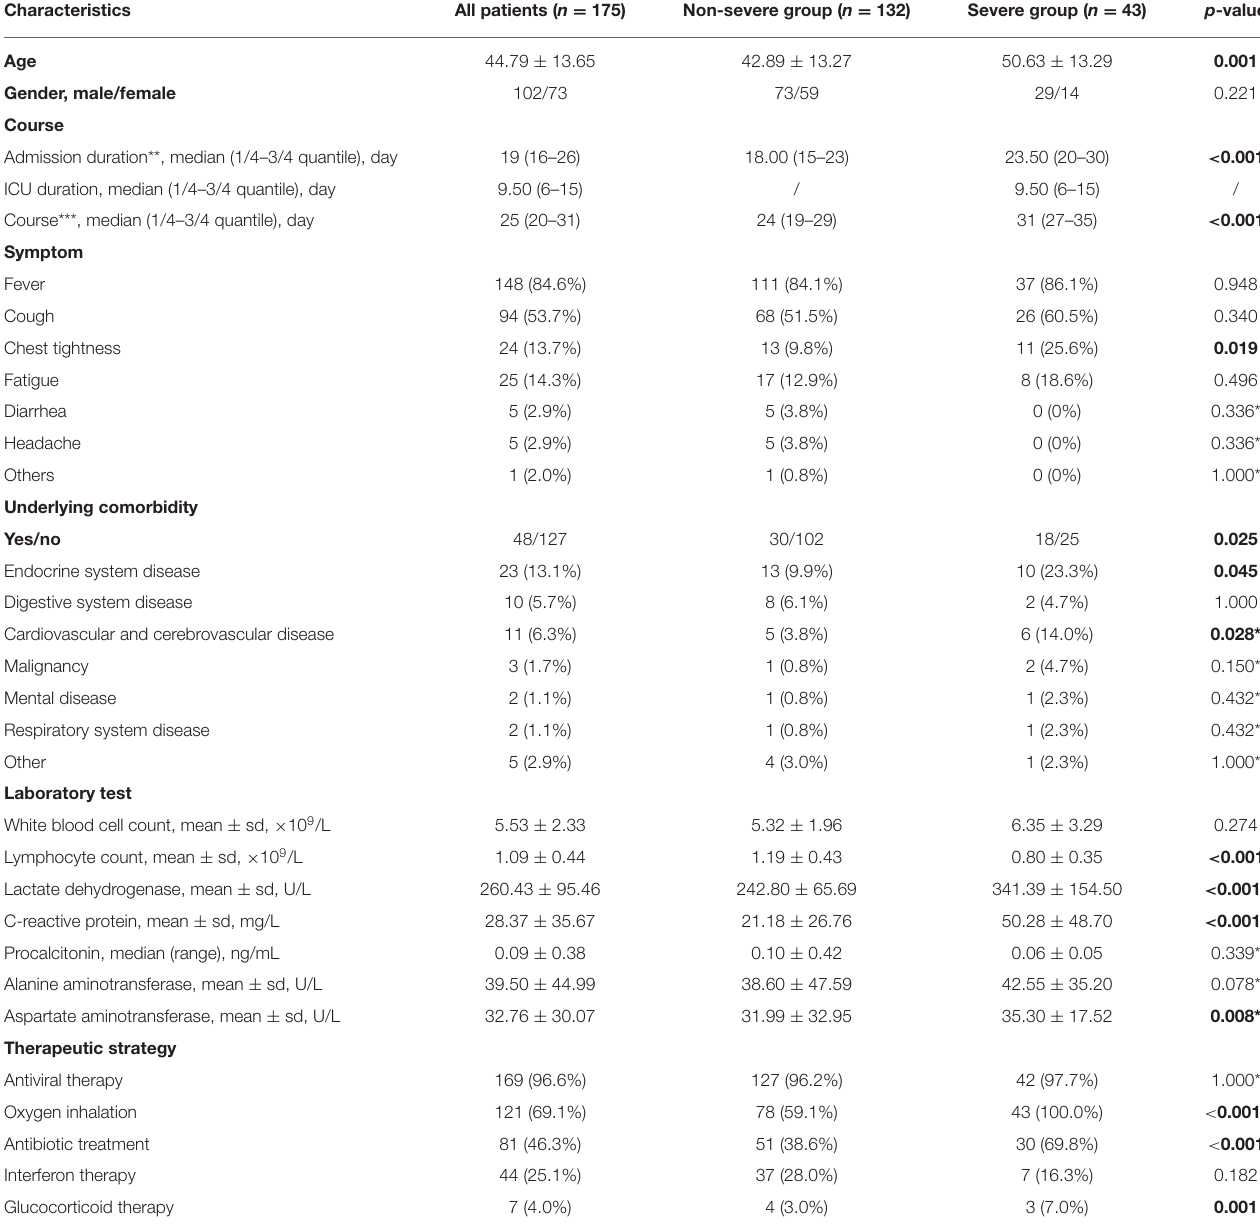
TABLE 1 | Predominant clinical characteristics and laboratory findings in patients from non-severe and severe group.